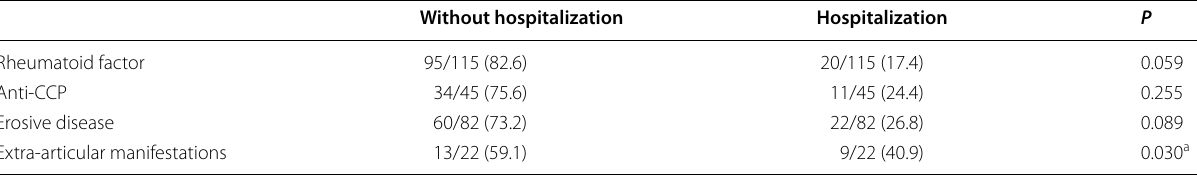
Table 3 Characteristics of rheumatoid arthritis in the studied